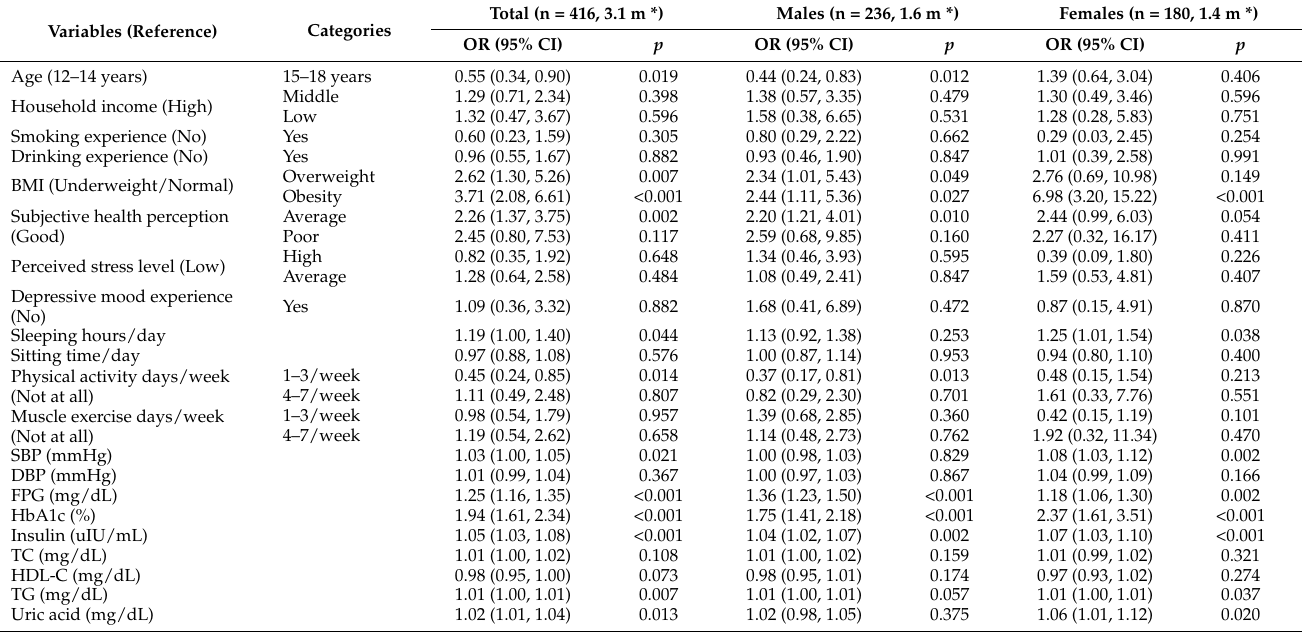
Table 3. Adolescent Factors Affecting the High-risk Group for Adolescent Diabetes.